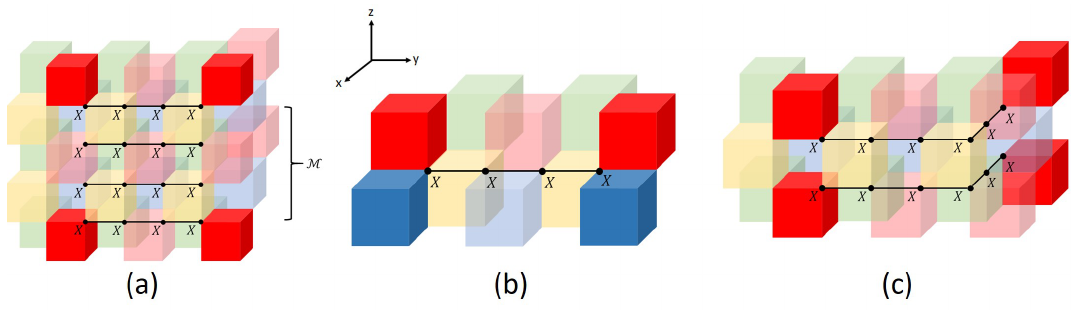
Figure 7: Hierarchy of excitations in the checkerboard model. (a) Fractons in a given sublattice are created at the corners of a membrane operator M as depicted. (b) Adjacent fractons belonging to distinct sublattices are lineons. (c) A pair of neigh- boring fractons belonging to the same sublattice is mobile along a plane and is hence a